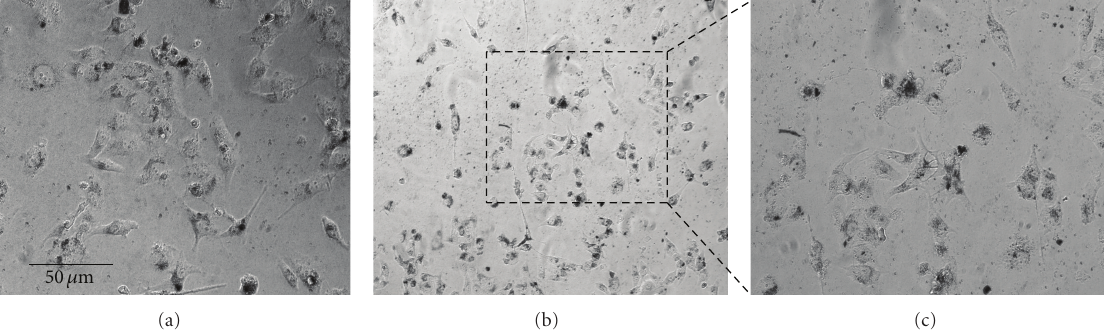
Figure 3: PNT1A cells (a) without PhAuNPs at 100x magnification and (b) with 4 𝜇 M bare PHAuNPs at 100x magnification and (c) shows the distribution of the PHAuNPs in aggregation on the substrate and cells at 200x magnification.